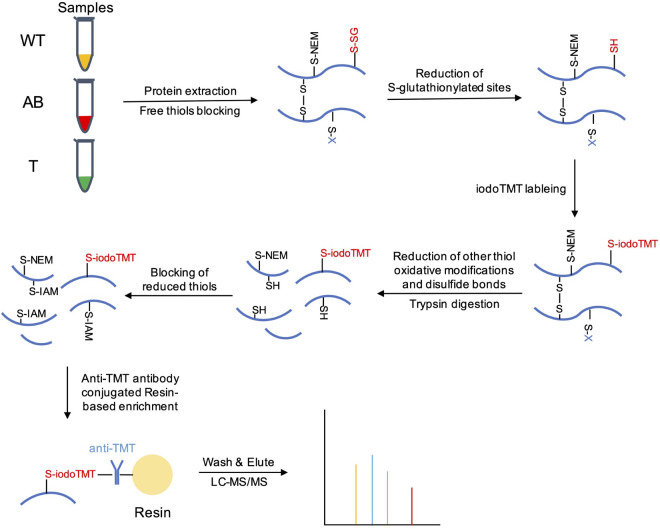
Schematic overview of isotopic-labeling strategy to identify and quantify S-glutathionylated proteins.NEM and IAM were used to alkylate free thiols. A cocktail of Grx, GR, GSH and NADPH was used to selectively reduce glutathionylated cysteines. 126 Da, 127 Da and 131 Da iodoTMT reagents were used to label groups WT, AB, and T, respectively. DTT was used to reduce disulfide bonds and other thiol oxidative modifications such as S-nitrosylation. Anti-TMT antibody-conjugated resins were used for specifically enrich the iodoTMT labeled peptides. The eluted peptides were subjected to LC-MS/MS analysis.